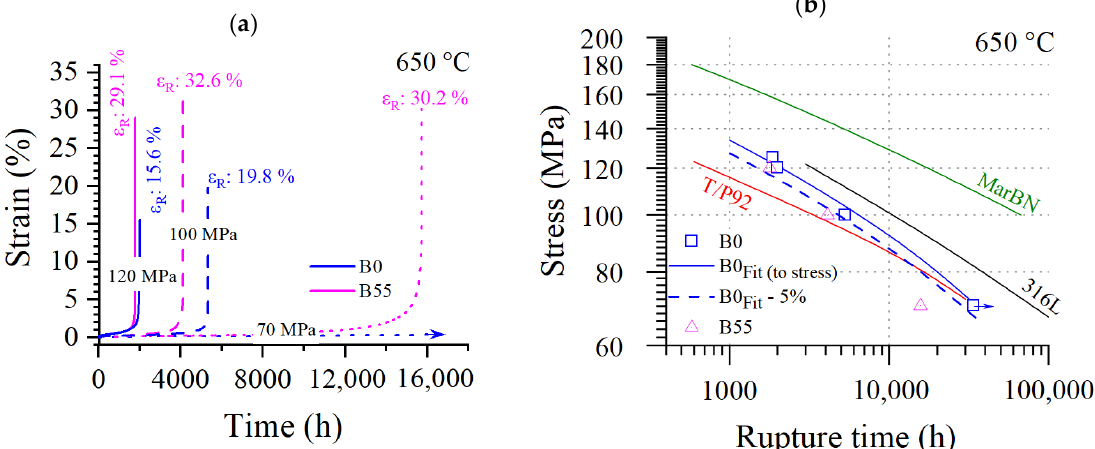
Figure 9. Creep curves (650 °C) of the trial steels. ( a ) Stress–rupture performance relative to the state- of-the-art structural steels used for power engineering (blue: B0, magenta: B55; solid lines: 120 MPa, dashed lines: 100 MPa, dotted lines: 70 MPa). ( b ) The 70 MPa experiment with the B0-alloy is still in progress—the fit line, for this reason, is still premature. Creep data were taken from B0 [6], MarBN [38], T/P92, 316L [39].